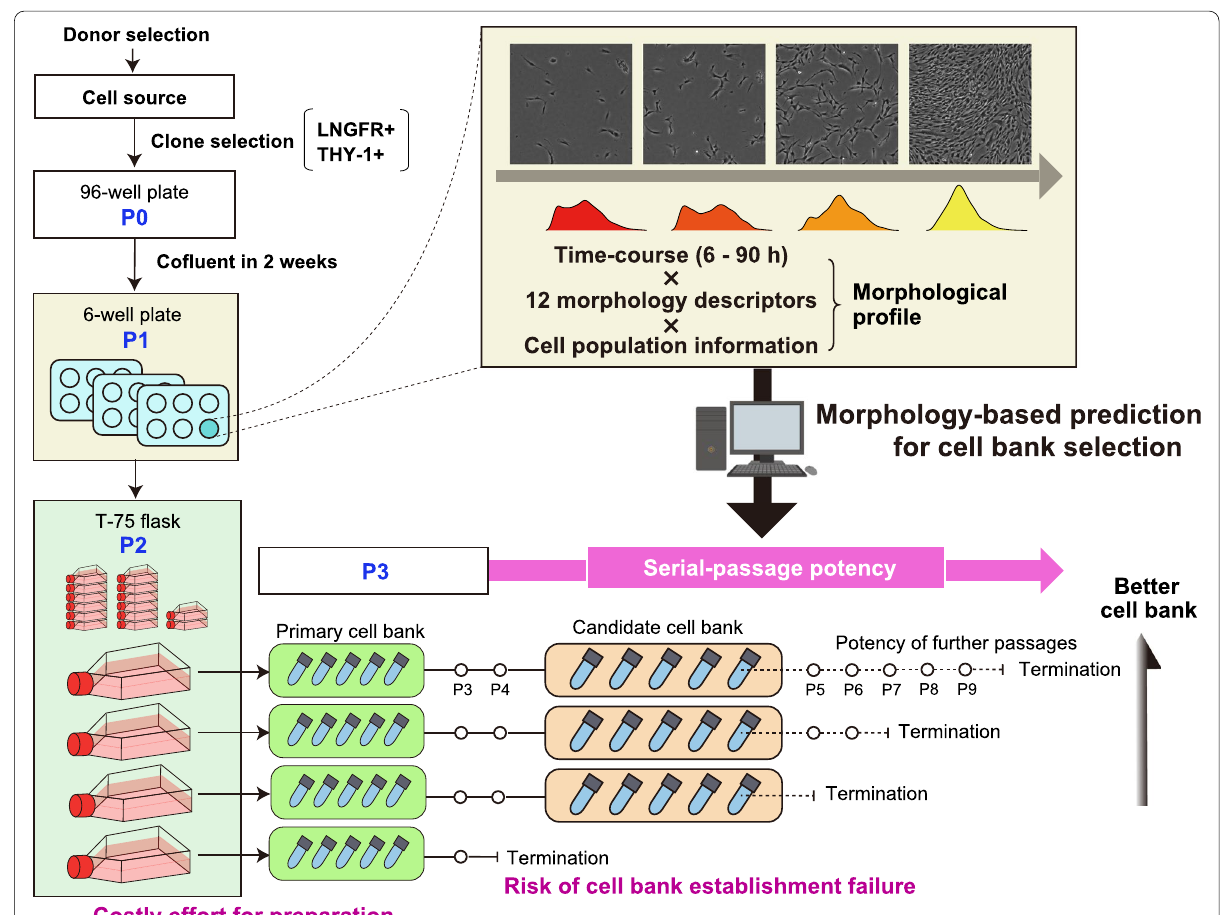
Fig. 1 Conceptual illustration of serial-passage potency prediction using a morphological profile for selecting a high-potency cell bank. The target RECs were sorted from the MSCs via the clone selection step (P1 and P2). At P3, cells were cryopreserved to form the primary cell bank for preparing early passage cells for further experiments. Serial-passage tests were examined from P3 till the limitation of the passage. For the practical cell-based therapeutic product manufacturing, the candidate cell bank is formed during such serial passages. However, there are risks; for example, cells show unexpected growth termination, which results in cell bank establishment failure. Furthermore, the formation of a better-quality candidate cell bank which possesses lower risks of having banked cells which loses further proliferation potency but has higher potency of further activity is expected. Such serial-passage potency was predicted from the morphological profile in the P2 stage cell images. The morphological profile comprises time course 12 morphological descriptors cell population information (mean and × ×